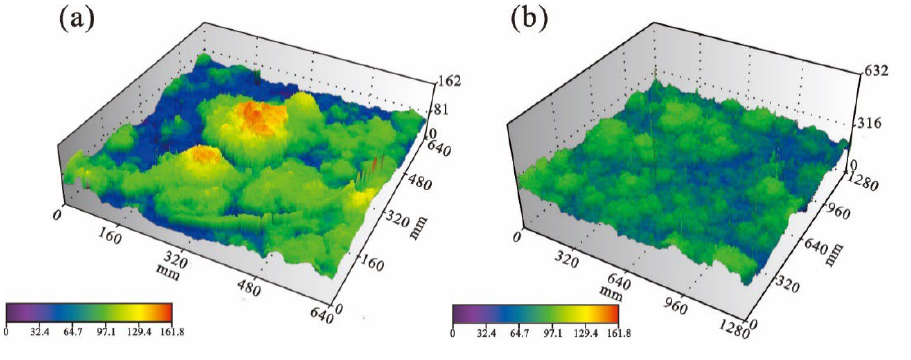
Figure 3. ( a ) Three-dimensional morphology of KNN coating. ( b ) Three-dimensional morphology of KNMN coating. KNMN coating.